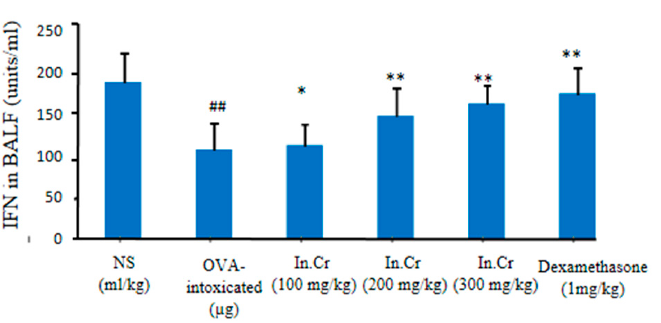
Figure 6. In.Cr more significantly boosted the levels of Interferons at 300 mg/kg by oral gavaging. The other doses of In.Cr also showed very effective results as expressed in the figure. The ovalbumin (OVA)-challenged group presented significant shrinkage in the levels of Interferon. ## p < 0.05 and ** p < 0.05 are more significant while * p < 0.01 is significant ( n = 8).